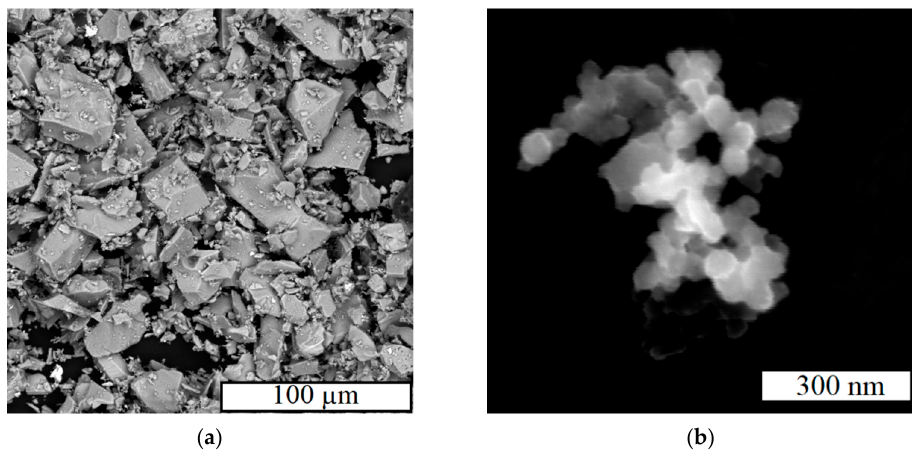
Figure 1. SEM images of the powders: micron-TiC ( a ), nano-TiC ( b ). Table 1. Chemical compositions of TiC powders.